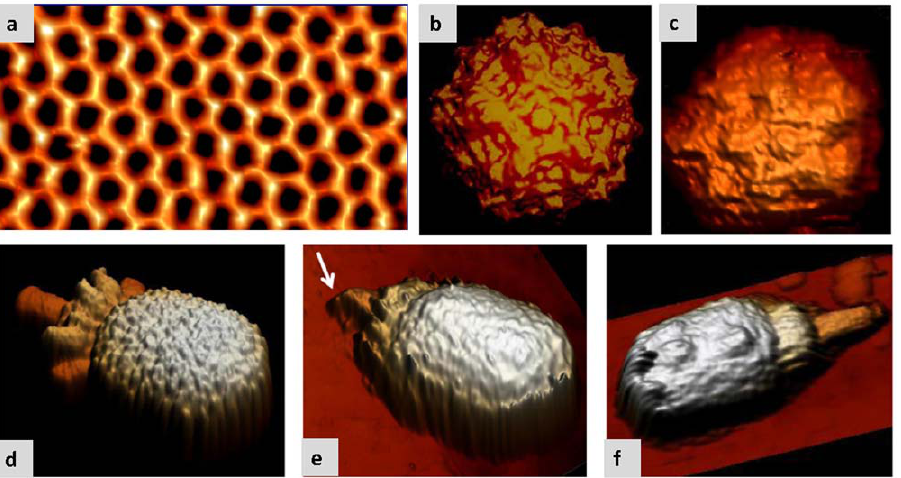
Figure 2. High resolution FM-AFM. Seeing individual features. (a) Image of a muscovite mica surface (001) showing true atomic resolution. The mica was immersed into a physiological buffer to ensure that under these conditions we are able to obtain true atomically resolved images. Parameters of the image: cantilever oscillation amplitude 0.5 nm and frequency shift 36 Hz, scan speed 800 nm/s, Resonance frequency 130 KHz, nominal spring constant 40 N/m. (b) View of a MVM particle oriented with a 5-fold symmetry axis on top as obtained from a molecular surface model derived from crystallographic data [36] as rendered in [11]. The capsid diameter is 25 nm. (c) FM-AFM topographic image of an individual MVM particle in the same orientation shown in (b).Virus particles were adsorbed on a glass surface immersed into a physiological buffer (PBS, 137 mM NaCl, 2.7 mM KCl, 1.5 mM NaH 2 PO 4 , 8.1 mM KH2PO 4 ). Parameters of the image: cantilever oscillation amplitude 0.9 nm and frequency shift 30 Hz, speed 350 nm/s, Resonance frequency 19 KHz. Calibrated spring constant of 0.6 N/m. (d) Cryo-EM model of the w 29 bacteriophage [24] (equatorial diameter , 45 nm) after a dilation process using a size tip of 0.2 nm. Reconstruction techniques are extremely precise but require the merging and averaging of a large set of images of individual viruses and, consequently, they tend to neglect individual particle features. (e) FM-AFM topographic image of an individual w 29 particle in TMS buffer (50 mM Tris pH7.8, 10 mM Mg Cl 2 , 100 mM Na Cl). This virus presents a damaged tail (see white arrow). Parameters of the image: cantilever oscillation amplitude 1.0 nm and frequency shift 31 Hz, scan speed 350 nm/s, Resonance frequency 35 KHz, calibrated spring constant of 1.8 N/m. (f) Another w 29 virus particle with a clear and well resolved tail but with some material bound to its head, forming extra protrusions. Parameters of the image: cantilever oscillation amplitude 1.0 nm and frequency shift 25 Hz, scan speed 350 nm/s, Resonance frequency 19 KHz calibrated spring constant of 0.6 N/m.